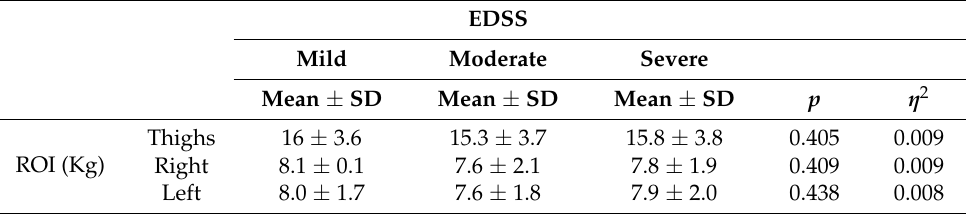
Table 4. Lean mass (kg) of the ROI as a function of neurological disability level by